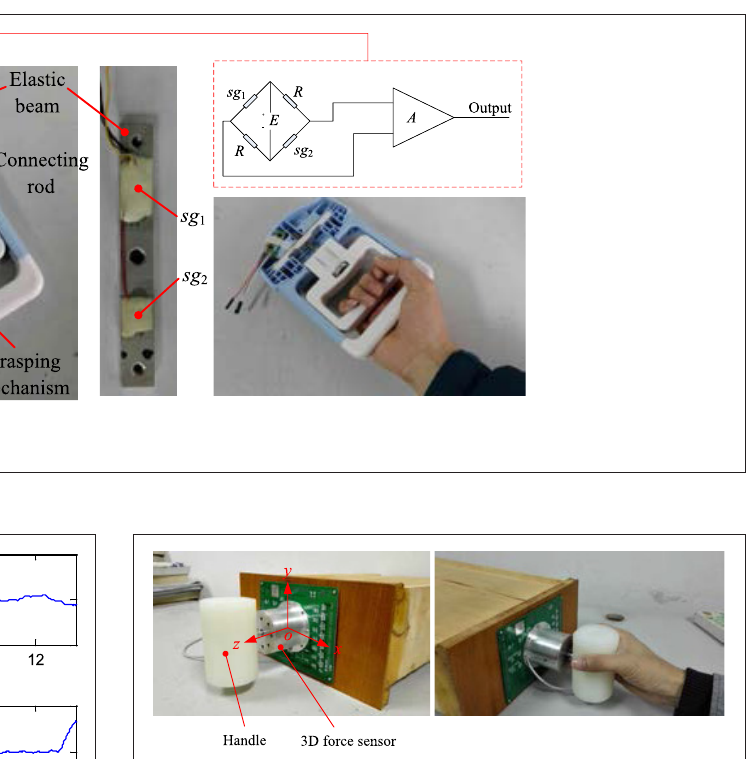
FIGURE 8 | The 3D force sensor and its manipulation